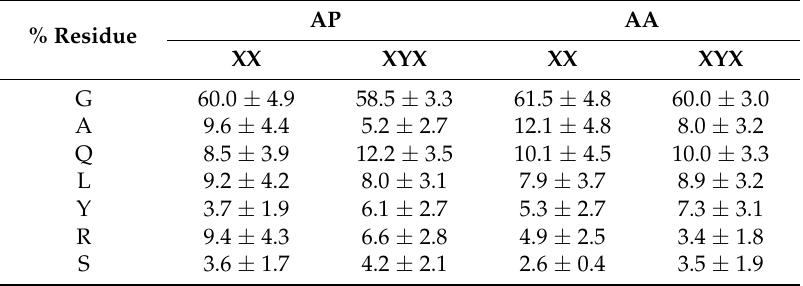
Table 3. Sequence composition of 3 1 - helices in the 300 K replicas. X indicates a residue with | φ | between 70 and 90 degrees, and | ψ | between 140 and 150 degrees; Y indicates any combination of dihedral angles.